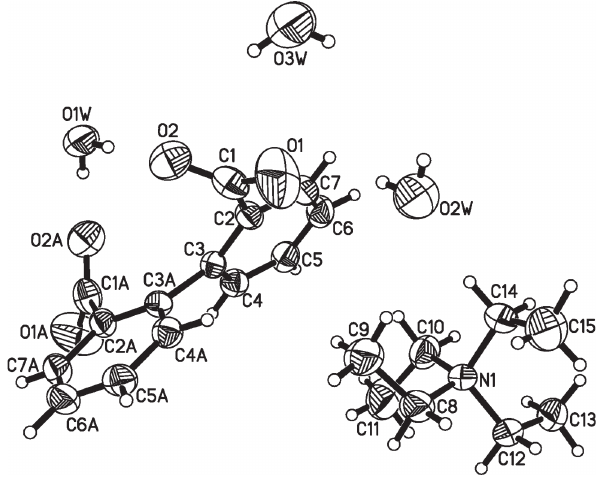
Table 1: Data collection and handling.